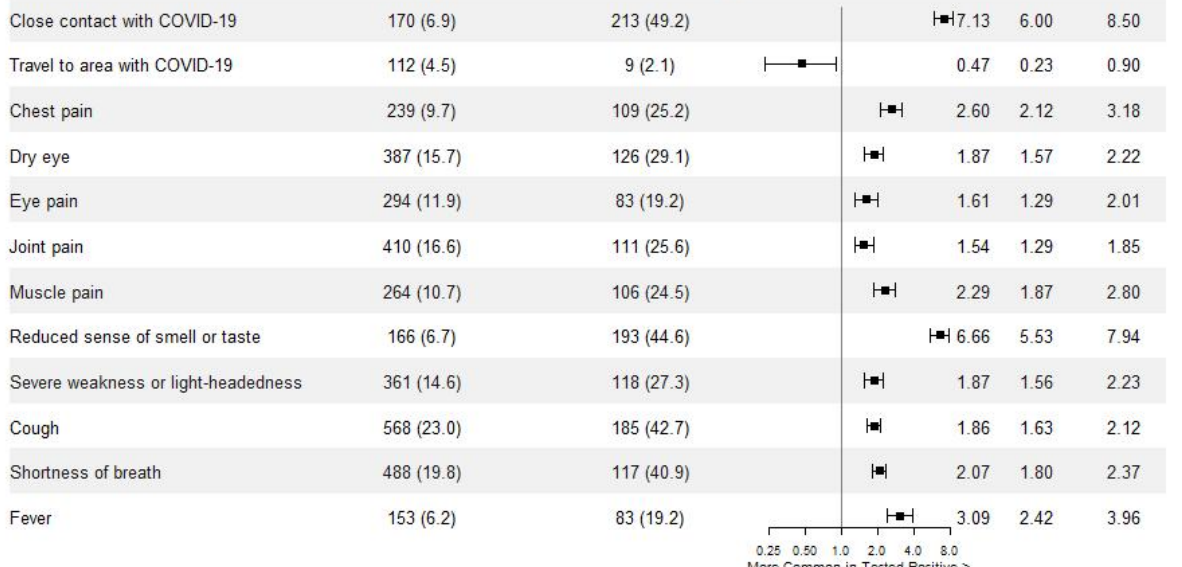
Figure 2. Forest plot presenting the RRs and 95% CIs of each item in the self-assessment questionnaire among users who reported testing positive for COVID-19 compared to those who reported testing negative. Muscle pain was not present in early versions of the self-assessment. Proportions were calculated for self-assessments where the symptom was reportable. RR: relative